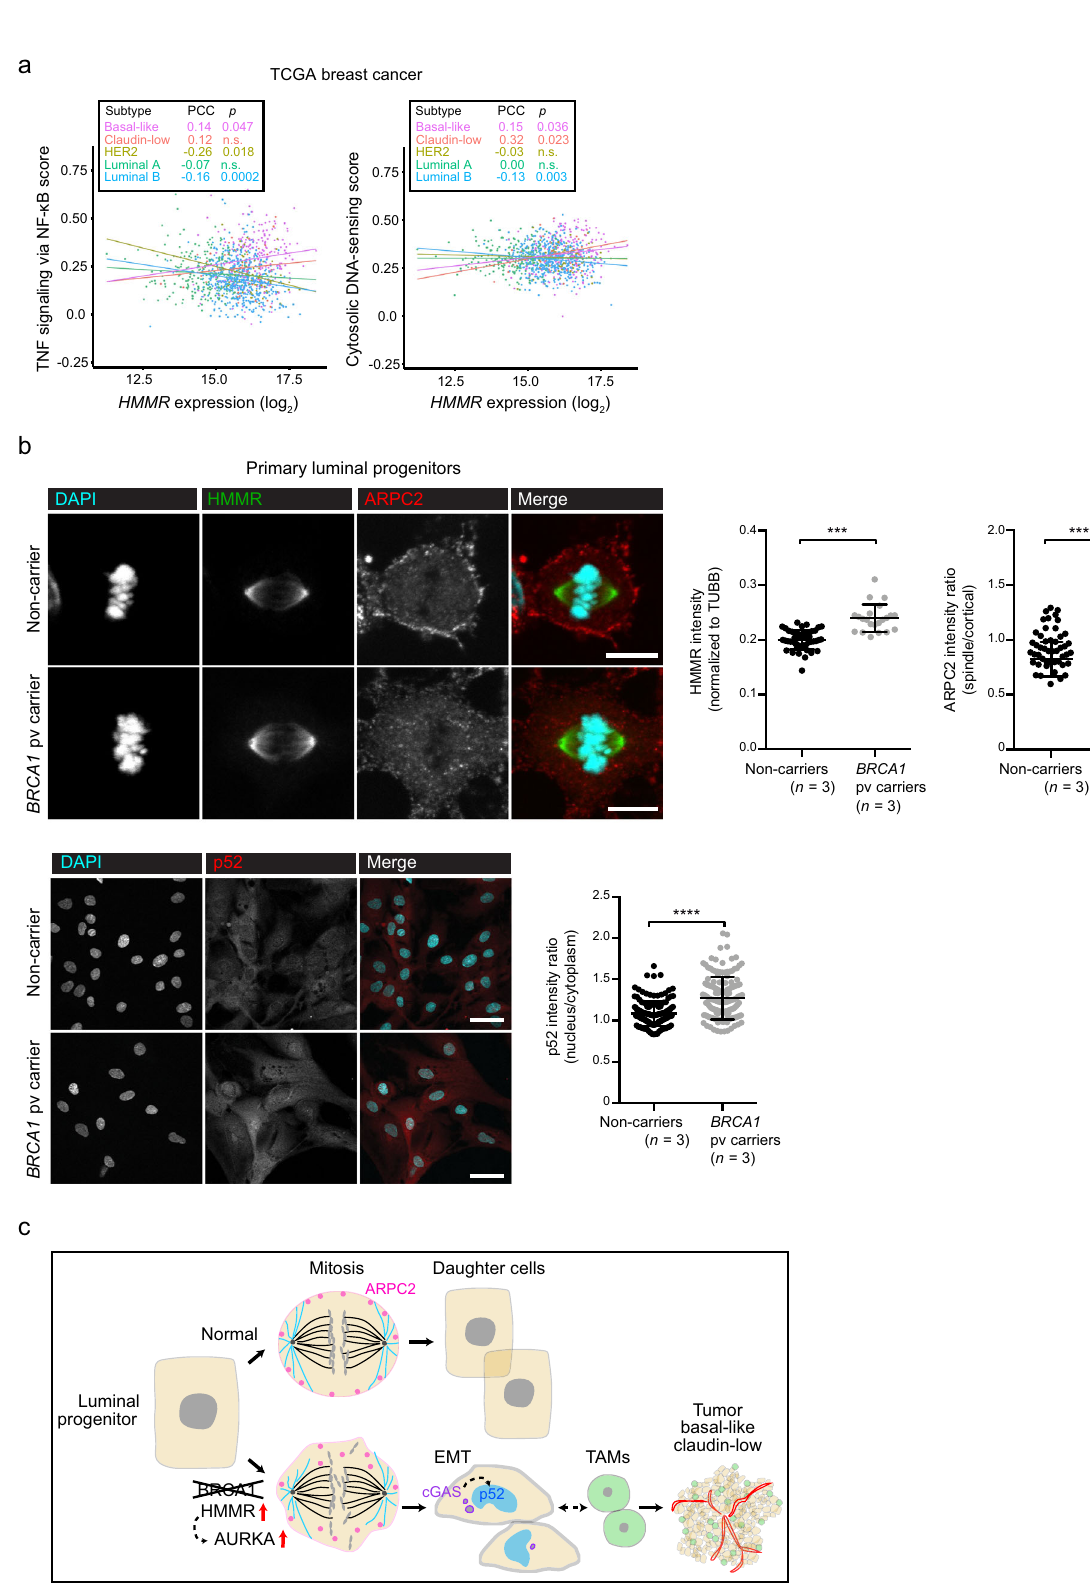
trimmed for adaptors, masked for low-complexity and low-quality sequences, and subsequently quanti fi ed for transcript expression using Kallisto 63 (version 0.43.16) and mouse genome version mm9. Gene-level quanti fi cation was carried out using the tximport 64 (version 3.14) Bioconductor package, mm9 and Ensembl v94 annotations. Differential expression was analyzed using DESeq2 65 (version 2.13). GO term enrichment was analyzed using clusterPro fi ler 66 (version 3.14) and GOnet 67 (version 2019-07-01). The pre-ranked GSEA 13 (version 4.1) method